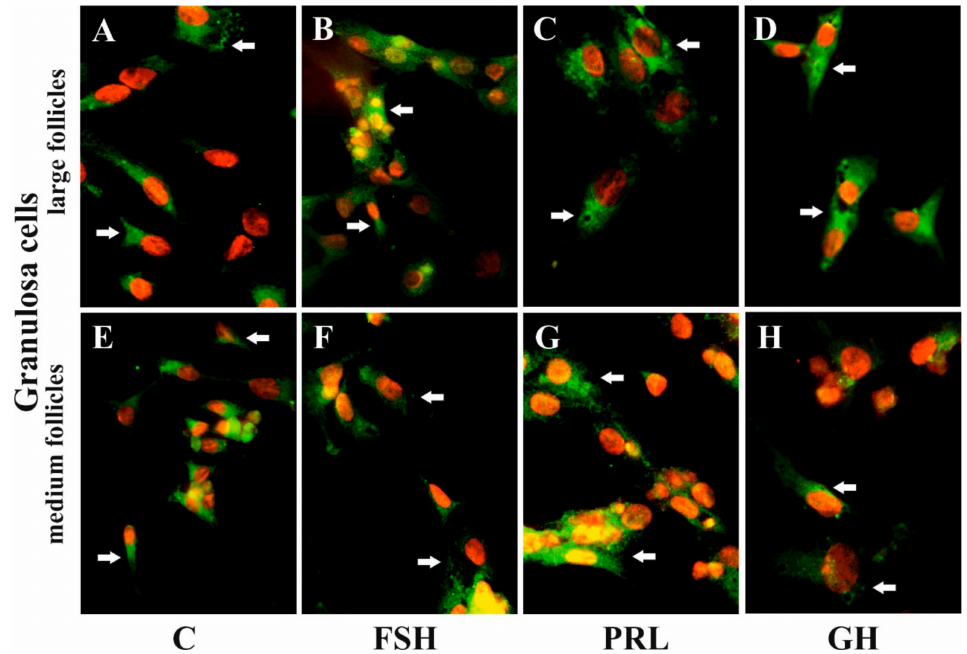
Figure 5. The influence of FSH, PRL, and GH on the subcellular distribution of AQP5 in the Gc of porcine ovarian follicles. After being exposed to FSH ( B,F ), PRL ( C,G ), and GH ( D,H ) for 24 h, Gc were incubated with anti-AQP5 antibody and visualized with Alexa-488 (in green). Nuclei were stained with propidium iodide (in red). Arrow indicates the localization of AQP5 in the cells. The data are representative of five individual experiments, each carried out in duplicate. C: control ( A,E ); magnification of 600 × .